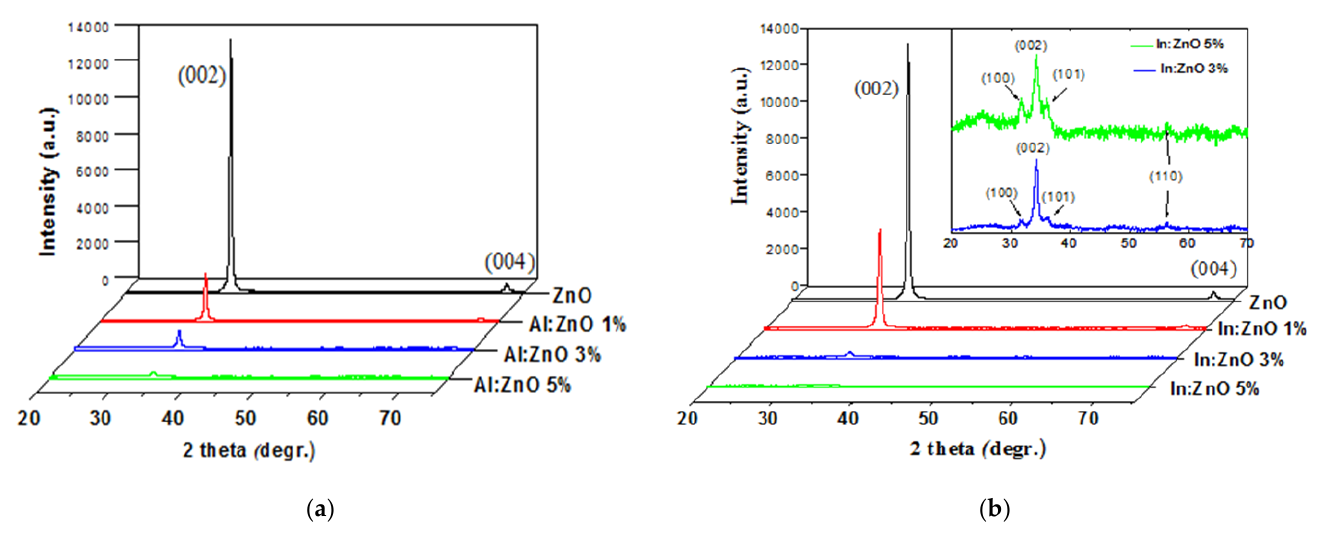
Figure 2. The X-ray diffraction patterns for undoped, AZO ( a ), and IZO ( b ) thin films.